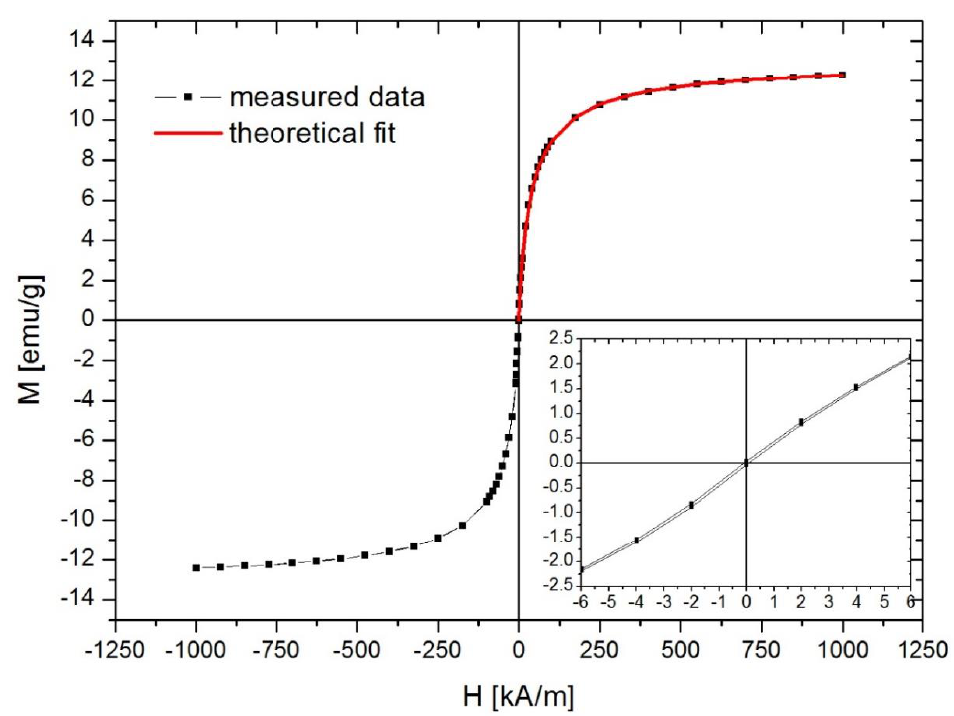
Figure 9. Magnetization (M) versus applied magnetic field strength (H) plot corresponding to the PMMA x -co-PDEAEMA y /PVP/Fe x O y magnetoactive electrospun fibrous adsorbent.